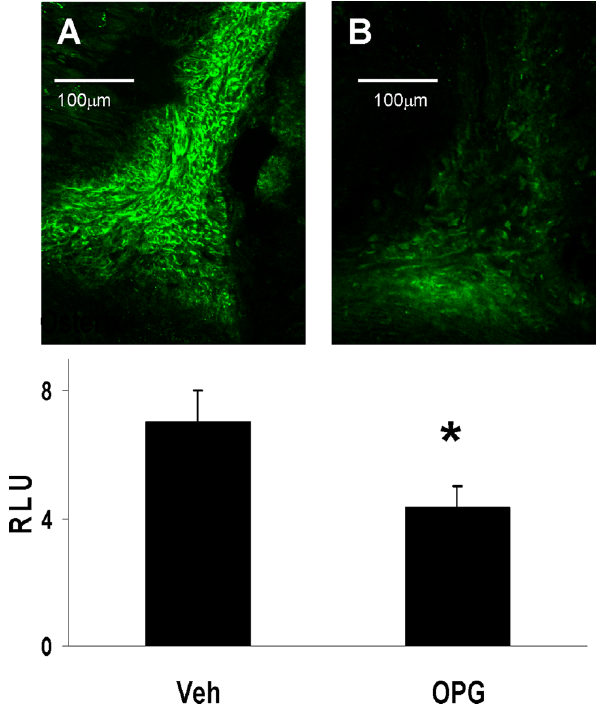
Figure 3. Immunofluorescent staining for osterix in the aortic valve in Young LA mice. There is abundant staining (green) at the cusp base in a vehicle-treated mouse ( A ), but less staining in the cusp base from an OPG-treated mouse ( B ). N=12. *p , 0.05 for Veh vs. OPG; RLU relative light units.